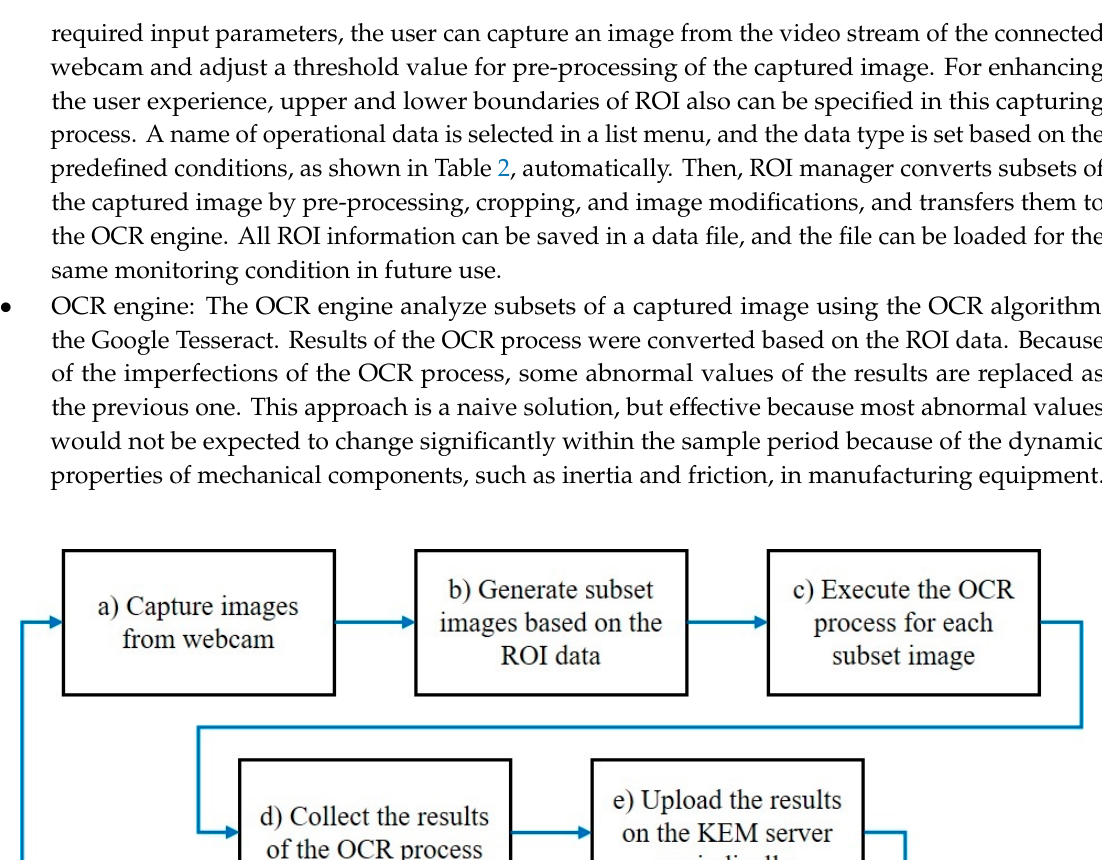
Figure 5. Working procedure of the KEM client.